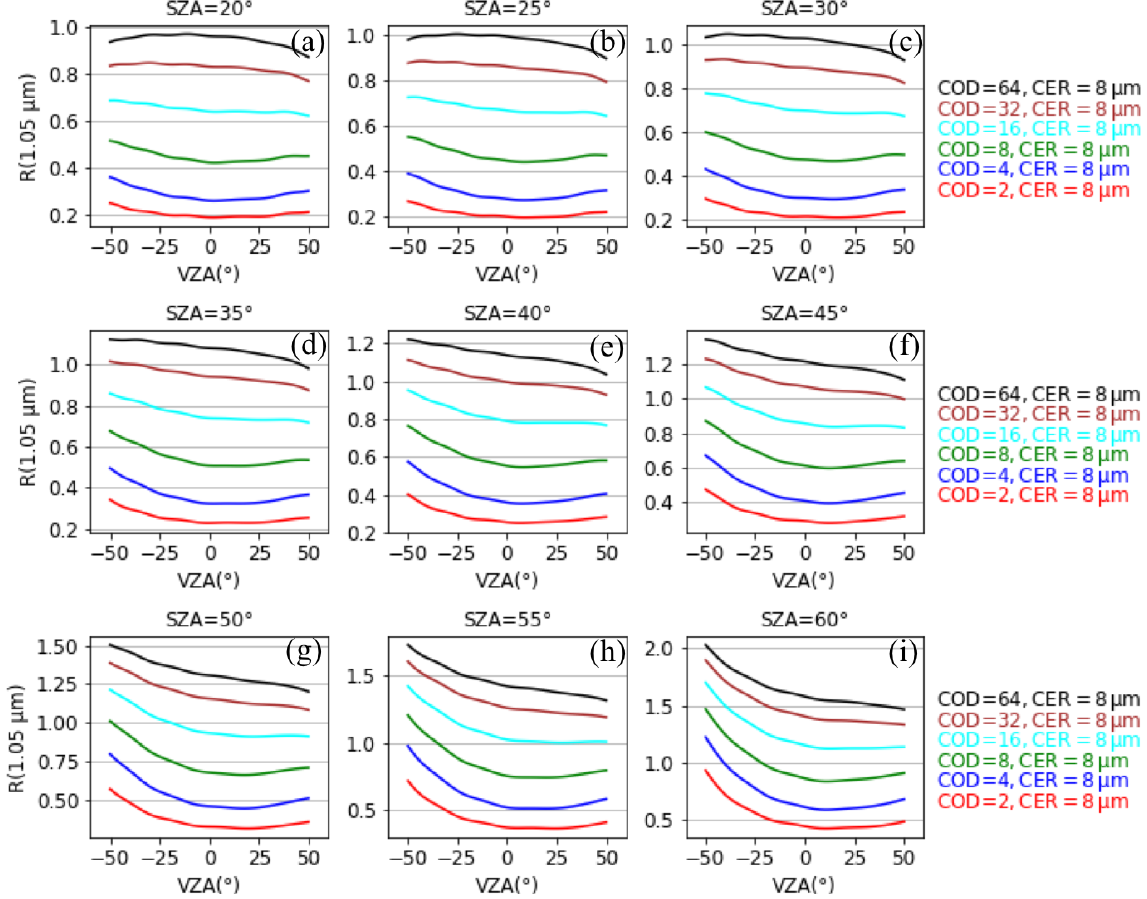
Figure 10. Relationship between R (1.05µm) and VZA for different COD values and fixed CER of 8µm for water clouds and different SZA values for the assumption of plane-parallel cloud layers. The negative and positive VZA values correspond to RAZ values of 135 and 45 ◦ , representing the forward and backward scattering directions,